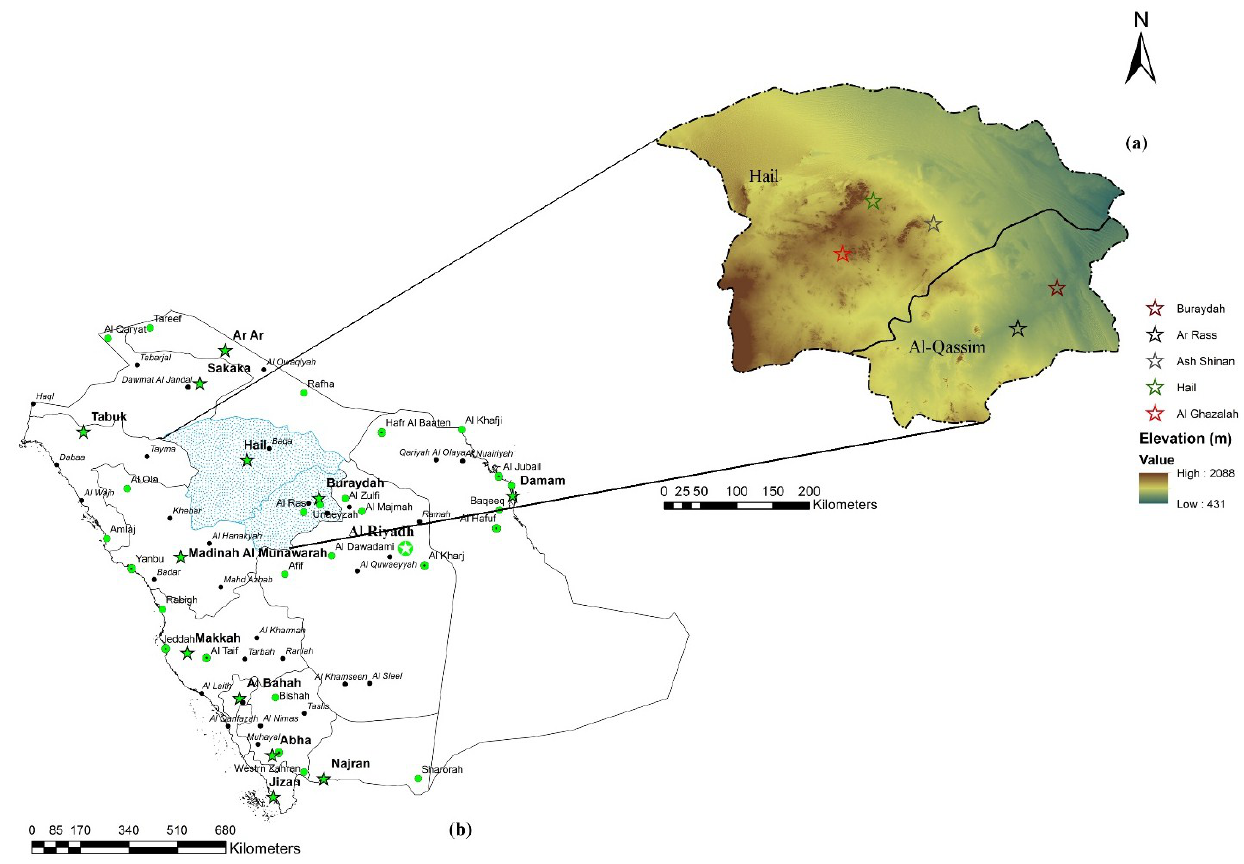
Figure 1. ( a ) Map of the administrative regions of the Kingdom of Saudi Arabia (KSA) with the indication of the study location (dotted blue area). ( b ) Digital elevation map for Al-Qassim and Hail with the study’s selected weather stations that are used in this